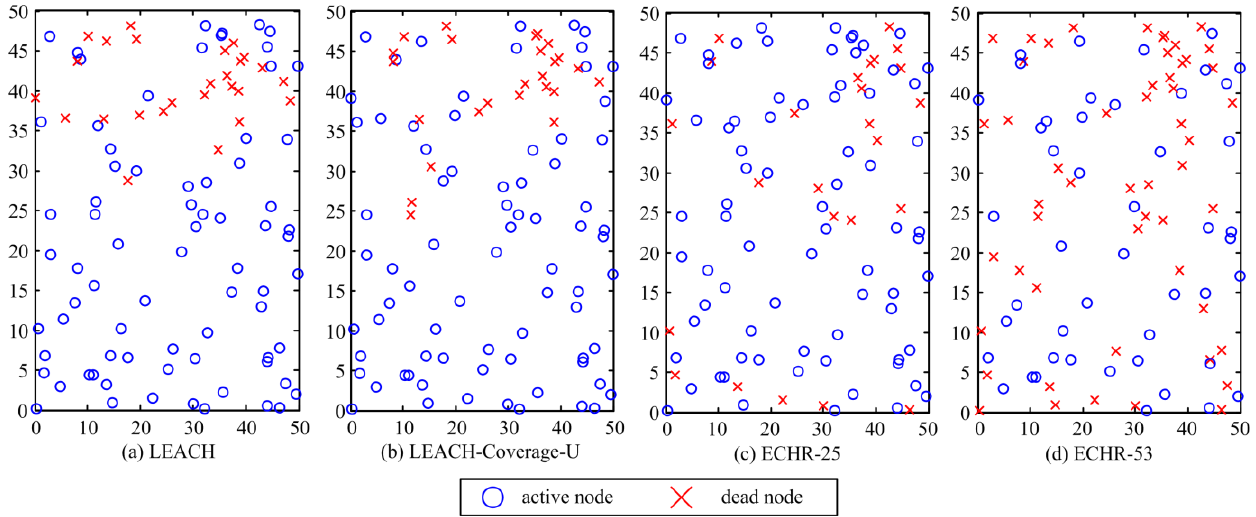
Figure 11. Distribution of alive and dead nodes yielded by ( a ) LEACH protocol, ( b ) LEACH-Coverage-U protocol, and ( c ) the proposed ECHR protocol. ( d ) Distribution of active and dead nodes before the network fails to maintain 100% sensing coverage obtained by applying the proposed ECHR